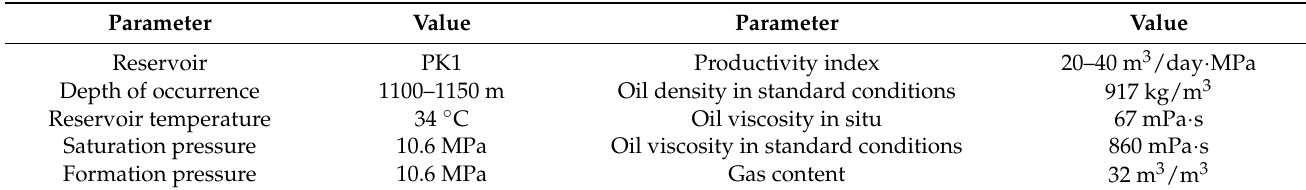
Table 1. Geological and physical summary of «Training» field.